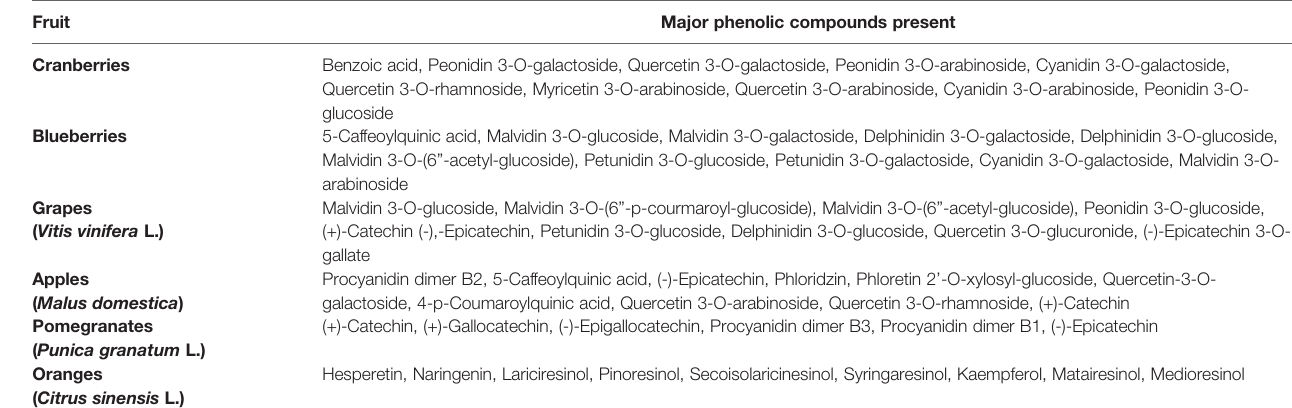
TABLE 1 | The major phenolic compounds found in cranberries, blueberries, grapes, apples, pomegranates, and